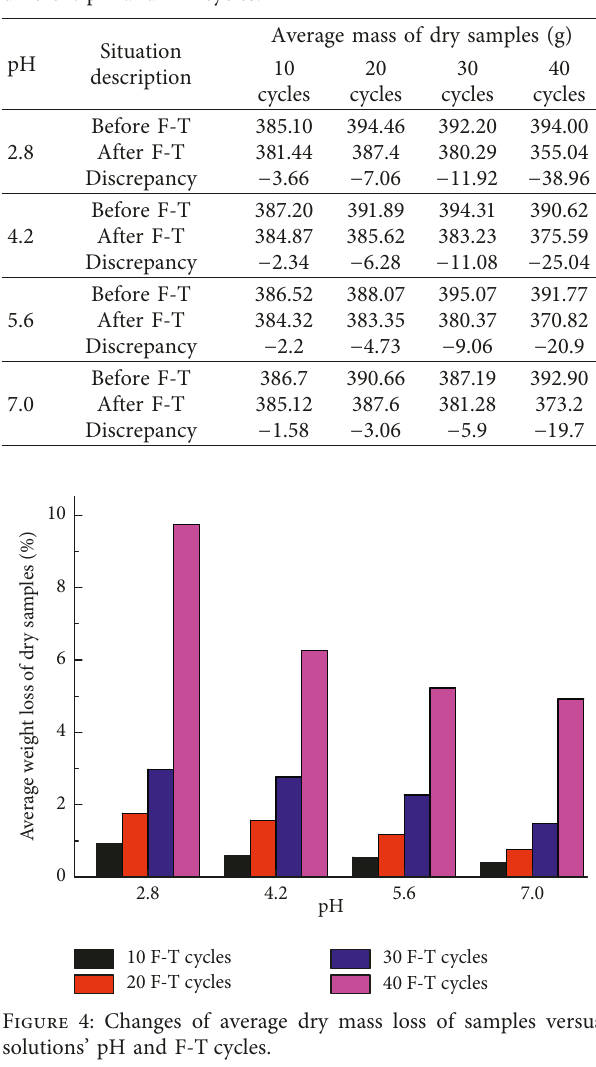
Table 3: Average dry mass of sandstone before and after suffering different pH and F-T cycles.